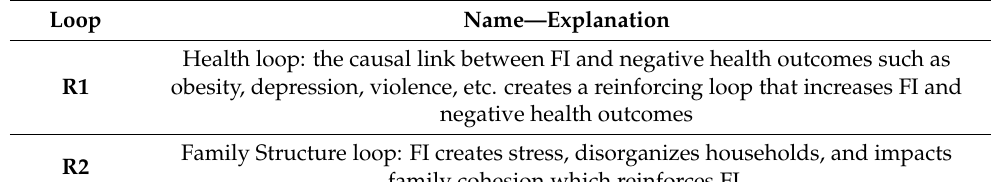
Table 2. The list of highlighted reinforcing (R) and balancing (B) loops in Figure